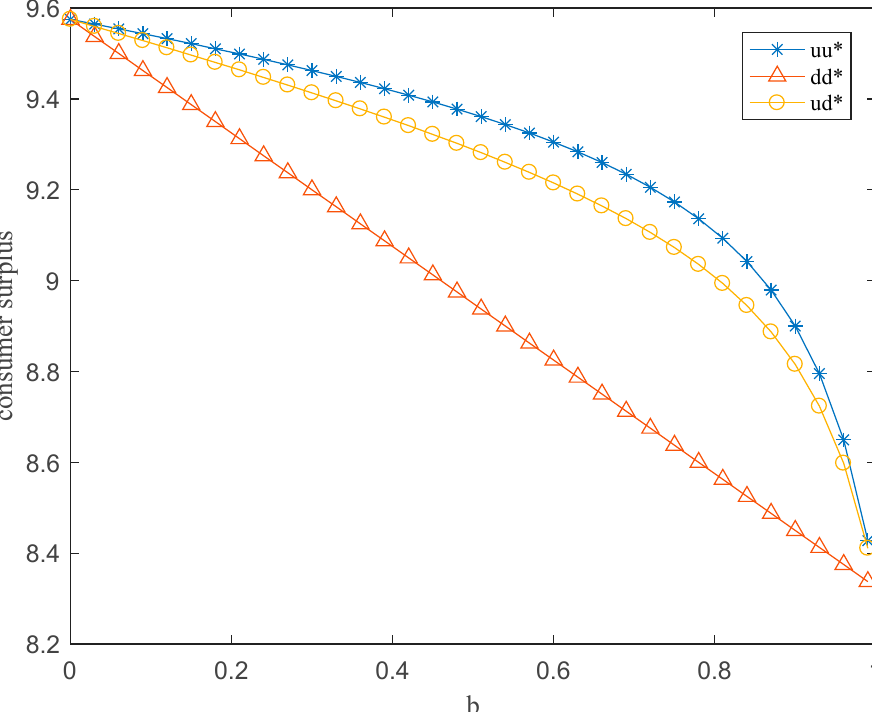
Figure 2. The total producer surplus under different situations.